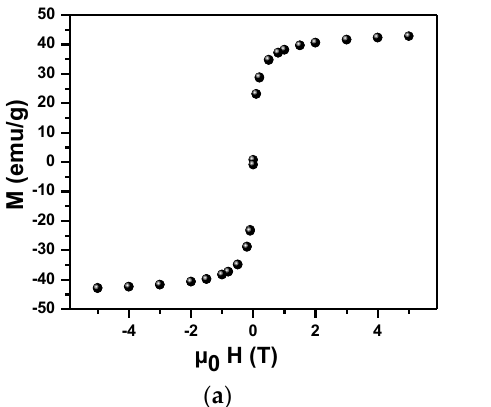
Figure 4. ( a ) Magnetization curve at 300 K and, ( b ) the temperature dependence of the ZFC/FC magnetization of the Fe 3 O 4 @Au pNPs.